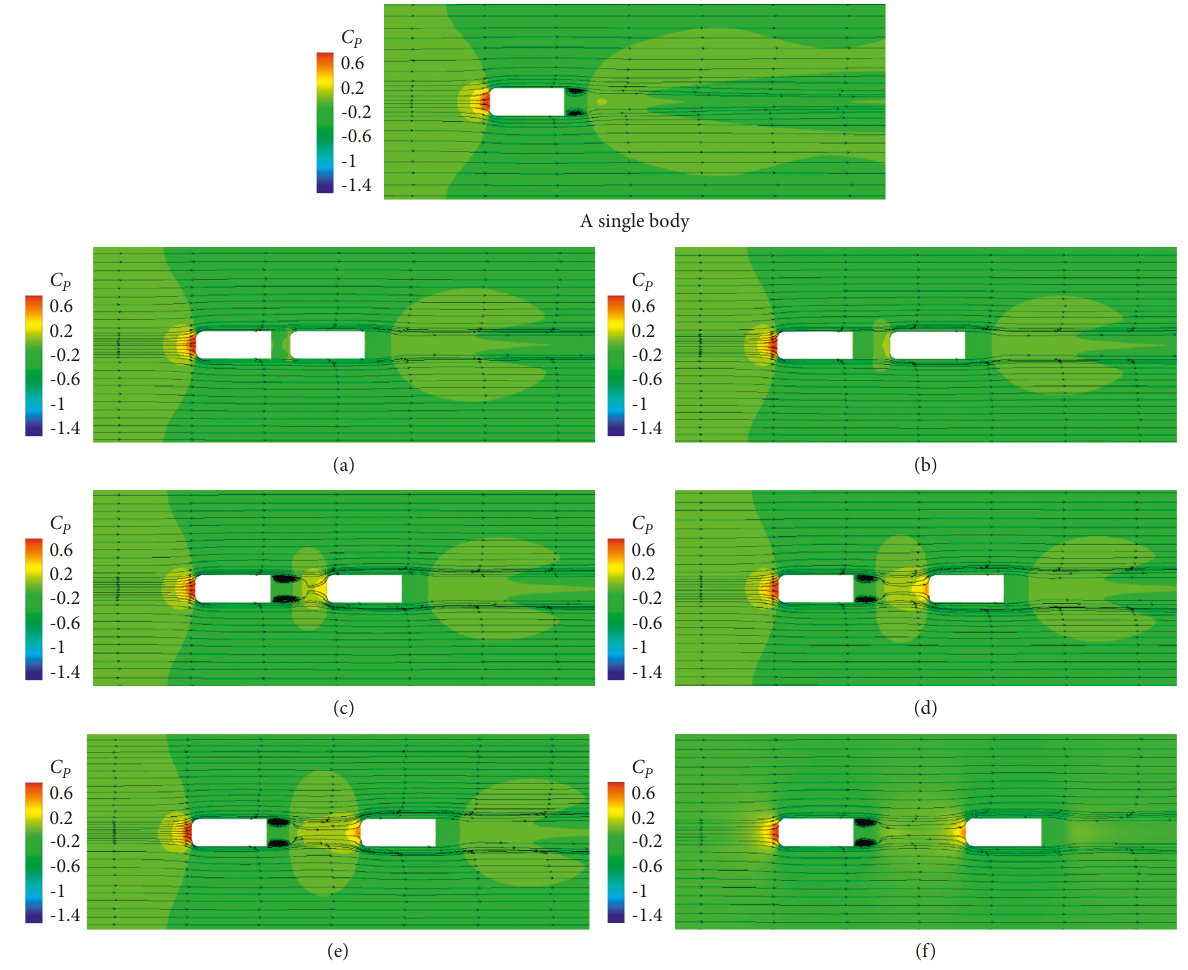
Figure 9: The pressure contour and streamline distribution of a single body and two bodies in the platoon on the z/(L) � 0.08 plane. (a) x/L � 0.25 (b) x/L � 0.5. (c) x/L � 0.75. (d) x/L � 1. (e) x/L � 1.25. (f) x/L �